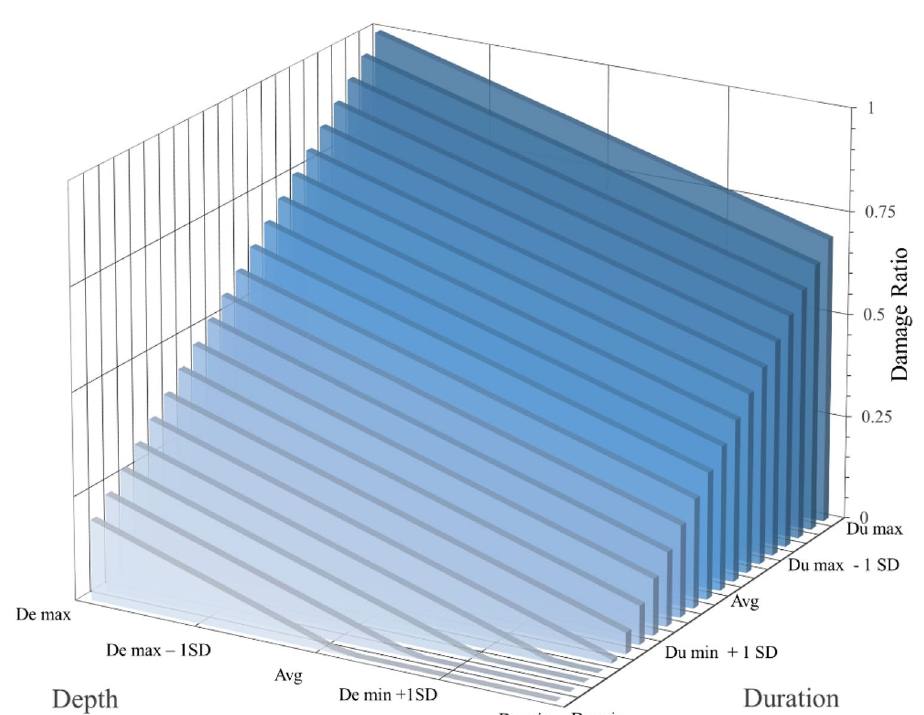
Figure 9. Building damage matrix from the experiment-based